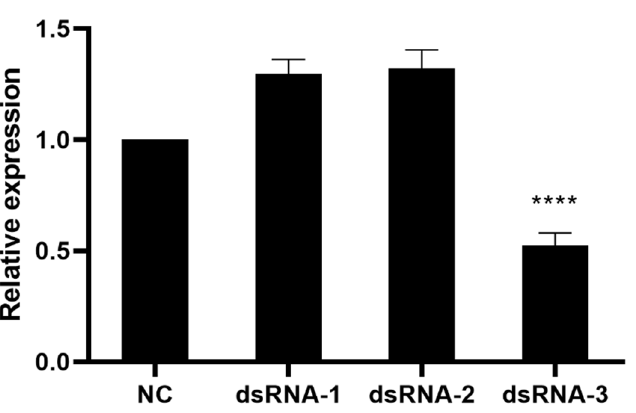
Figure 5. The relative expression level of the UGT46A1 gene in the experimental group relative to the negative control group after 48 h of the injection of different dsRNA fragments. NC: Negative control. Actin A3 was the internal control. The expression of negative interference fragments injected (quantity was 1) was used as the NC group. The expression of other interference fragments injected was relative compared with the control group. **** indicates statistically significant ( t -test, p < 0.0001). All data were presented as the mean ± SD (n = 3).